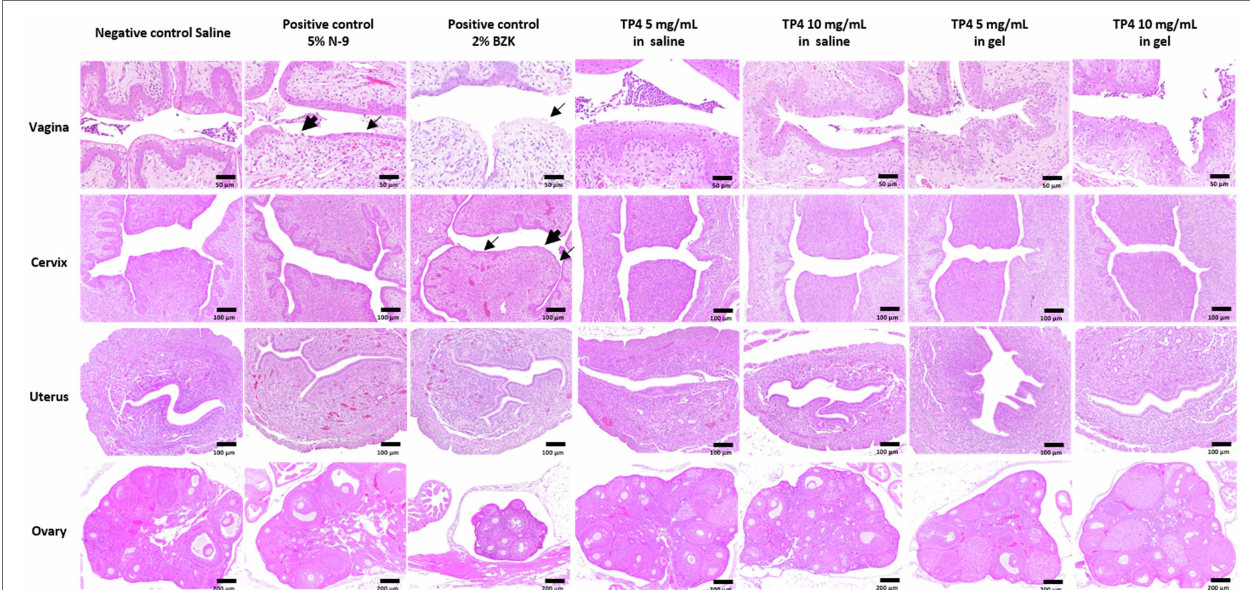
FIGURE 7 | Tissue toxicity following vaginal administration of TP4 microbicide formulation in mice. Eight-week-old female C57BL/6 mice were used to evaluate tissue toxicity following vaginal administration of TP4. Hematoxylin and eosin (H&E) staining of mouse reproductive organs excised 24 h after intravaginal administration of saline (negative control), 5% N-9 (positive control), 2% BZK (positive control) and TP4 at 5 or 10 mg/ml in saline or gel (TP4 microbicide formulation). Vehicle gel contains 0.1% chitosan and 0.4 mM disodium EDTA in saline. Epithelial thinning and erosion are indicated by fine arrows and arrows, respectively. Images are representative of n = 5 mice. Scale bar applies to all